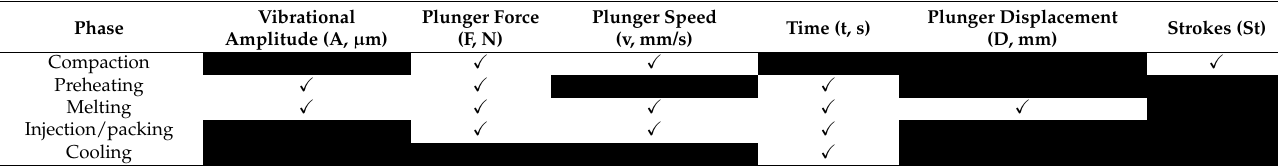
Figure 1. Ultrasonic molding technology: ( a ) Sonorus 1G machine, ( b ) main elements, ( c ) specimen and ( d ) specimen regions: start (A) and end (B). Table 1. Process parameters in ultrasonic molding